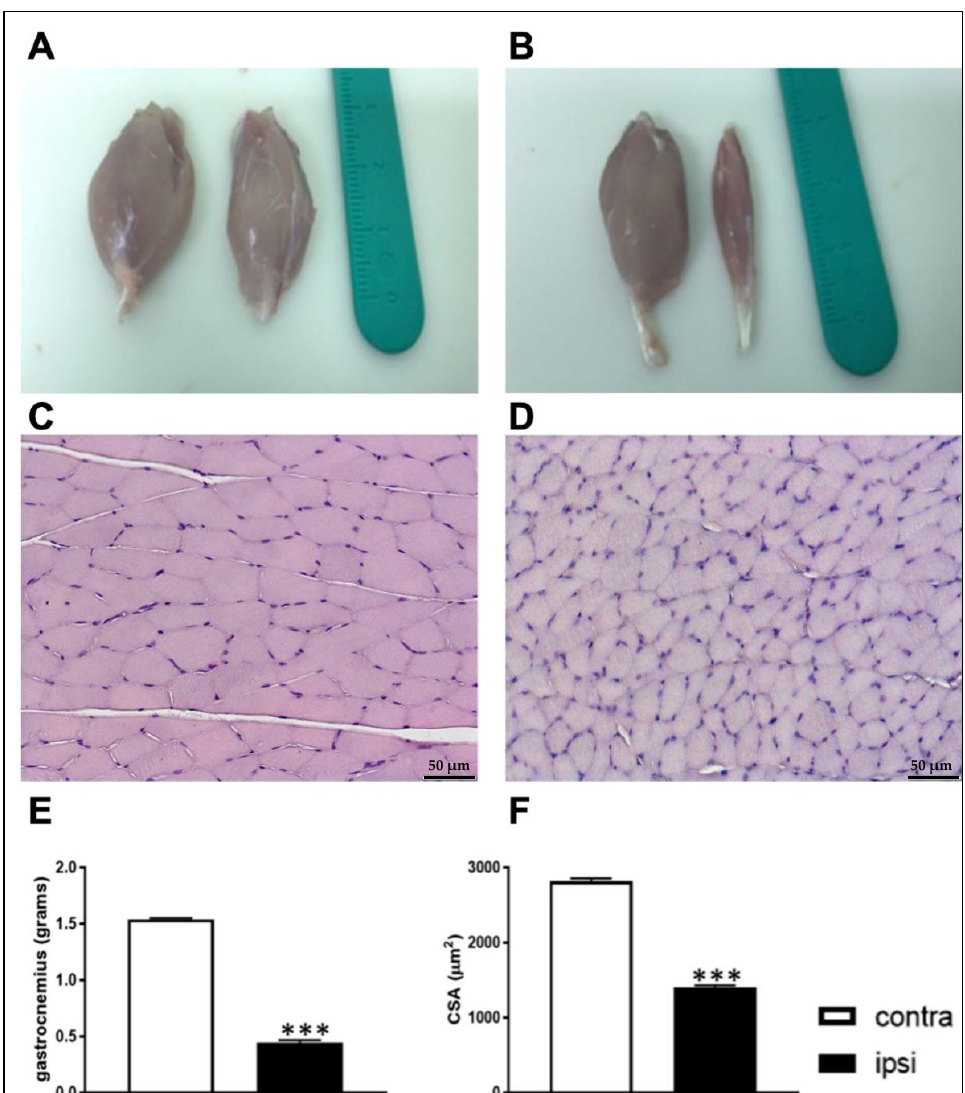
Figure 4. GC muscles of rats, subjected to CCI, exhibited an atrophic phenotype on day 28. (Top) Representative photos of GC muscles of a naïve animal ( A ) and a CCI animal ( B ) explanted on day 28 of the experiment showed a muscle-wasting phenotype. (Middle) Representative haematoxylin and eosin (H&E) staining images of contralateral GC ( C ) and ipsilateral gastrocnemius ( D ) showed a reduction in the CSA of muscle fibers in CCI. Scale bar: 50 µm . (Bottom) GC weight on day 28 was reduced in ispilateral hindlimb compared to that of the contralateral ( E ); also, CSA of muscle fibers was reduced in ipsilateral GC compared to that of the contralateral ( F ). The results are expressed as mean ± S.E.M. ***: p < 0.001 vs. contralateral.